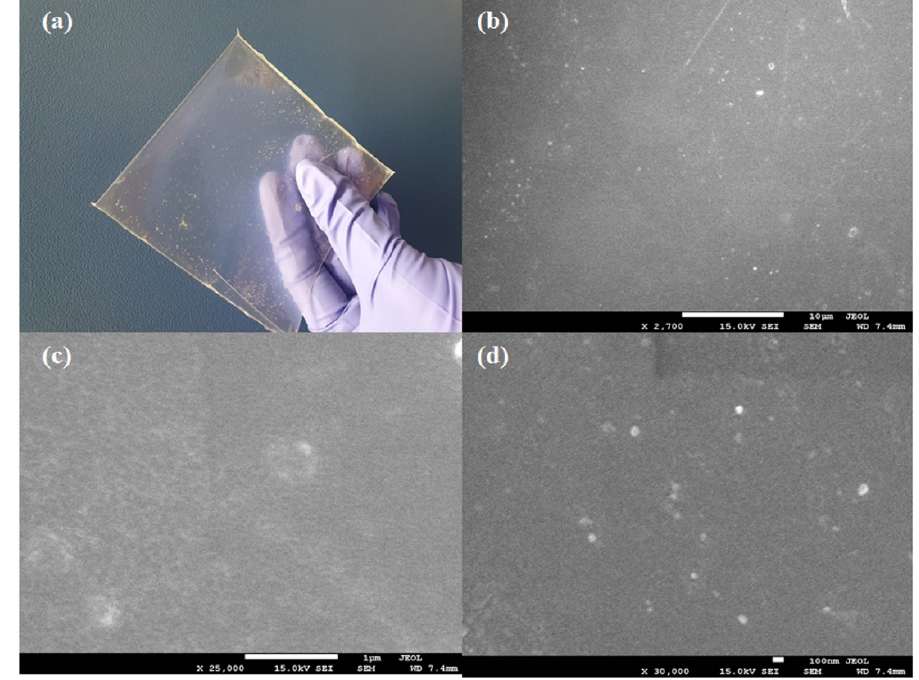
Figure 9. ( a ) Optical image; SEM images of ( b ) MEM1-0% QCS, ( c ) MEM2-5% QCS, and ( d ) MEM3-10% QCS.